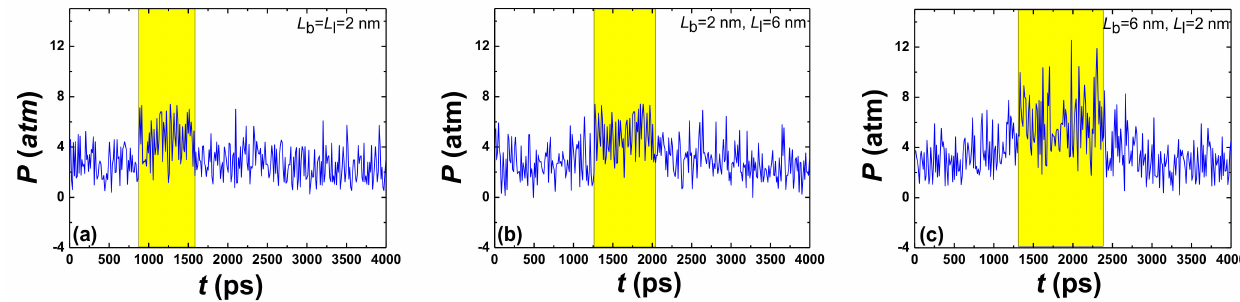
Figure 6. The average pressure on the surfaces at θ l = 160 ◦ with ( a ) L b = L l = 2 nm, ( b ) L b = 2 nm, L l = 6 nm and ( c ) L b = 6 nm, L l = 2 nm. The left ordinate of the yellow region denotes the time when the pressure starts to increase, while the right one denotes the time the pressure returns to the previous